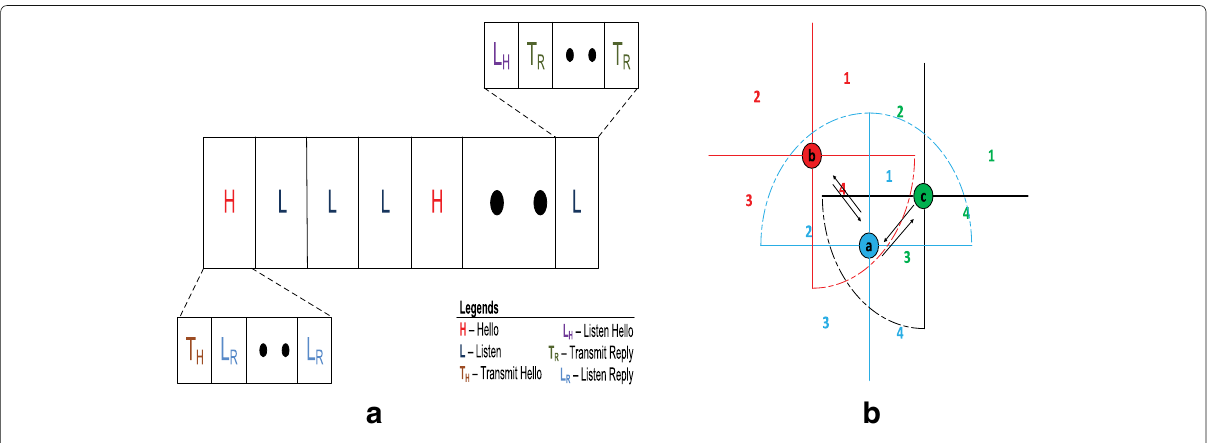
a b Fig. 2 Frame structure and neighbor discovery in COND system. a Frame structure. b Neighbor